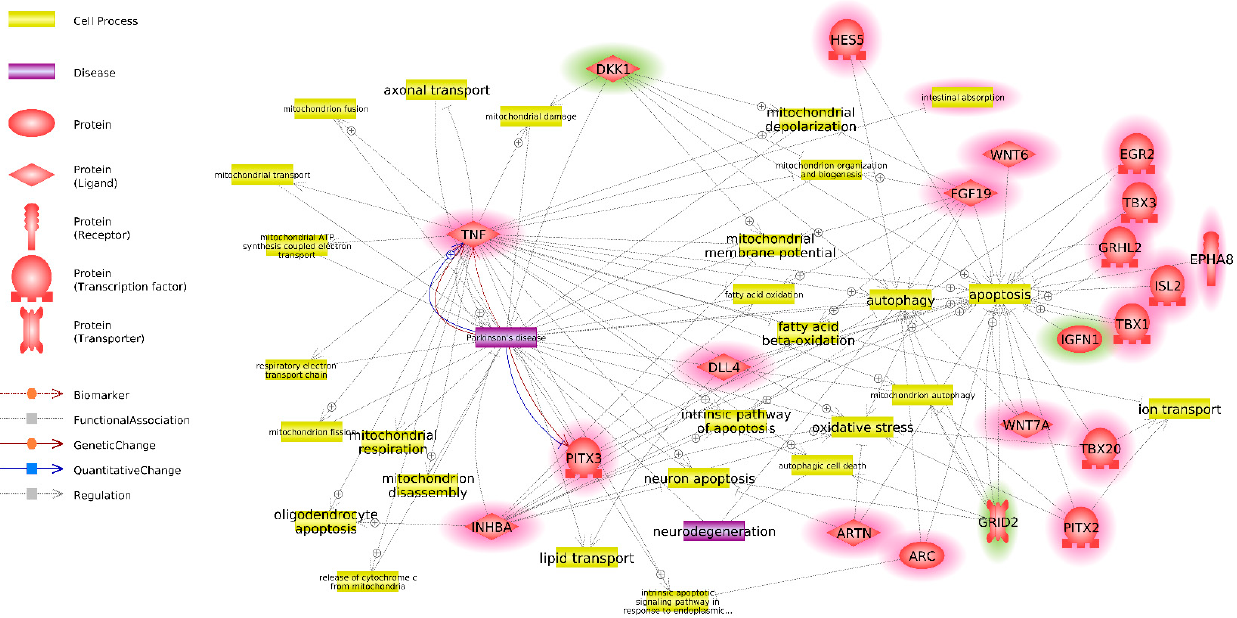
Figure 4. Interaction network of DEG NPC, associated with significantly enriched GO BP terms from groups I and II and diseases and metabolic processes, identified using key words “Parkinson”, “neurodegeneration”, “transport”, “vesicular”, “mitochondria”, “lysosome”, “oxidative stress”, “apoptosis” and “autophagy” based on Pathway Studio data. Genes, overexpressed in NPC derived from twins with PD, as compared to NPC derived from healthy twins are highlighted red. Genes, underexpressed in NPC derived from twins with PD, as compared to NPC derived from healthy twins are high- lighted green.